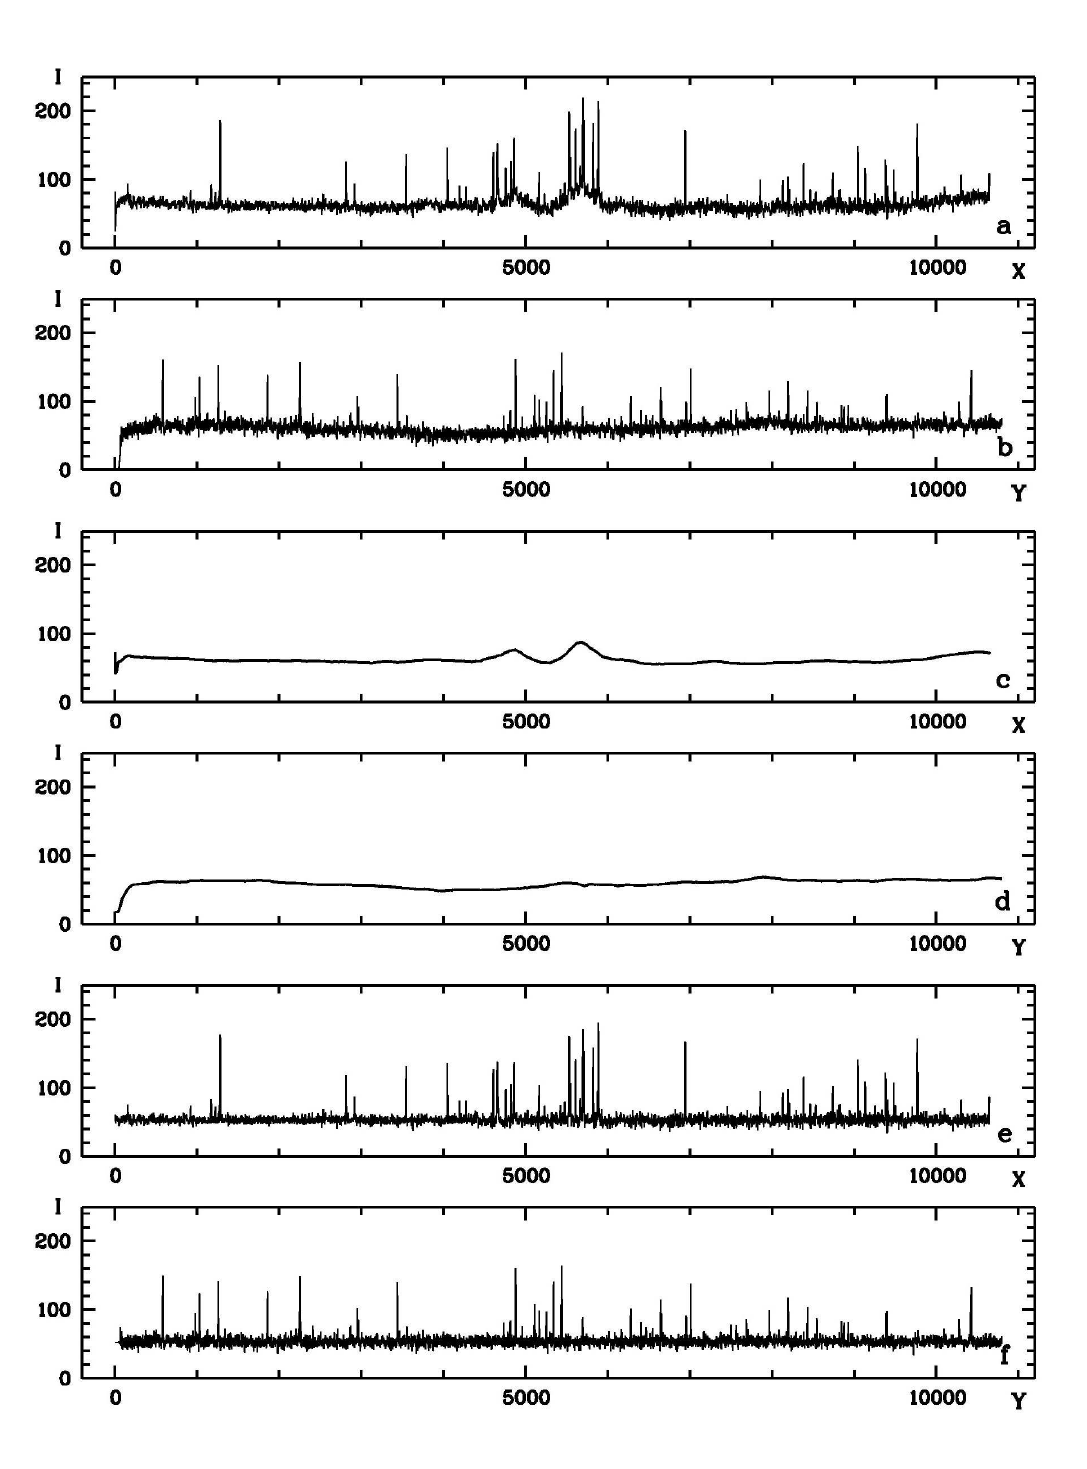
Figure 1. The example of the central photometrical slices for coordinates X and Y for the plate Nr.6978. On the top two panels ¬ for the orig- inal scan, on the middle two ¬ the slice for the tangents of the flat plate field, on the bottom ¬ the resulting slices after the correction of the original slices according to the tangent of the flat plate